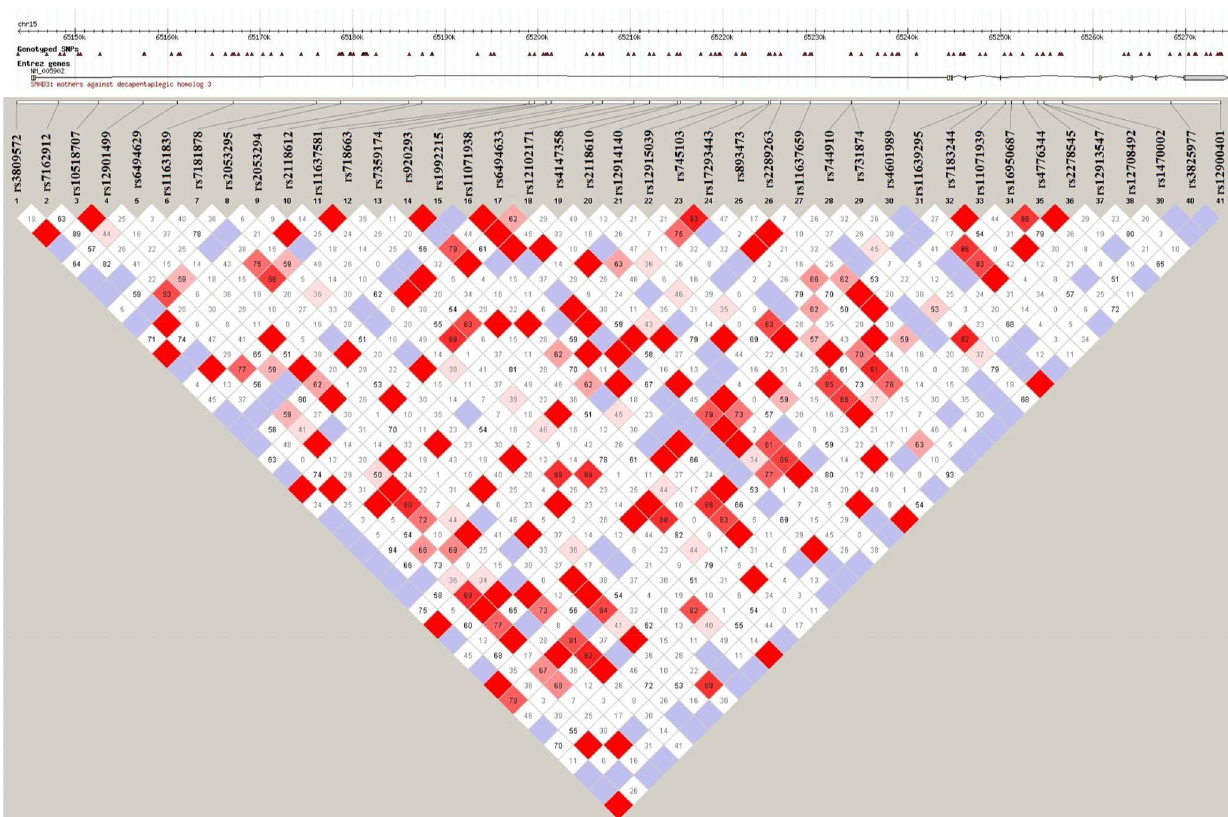
Figure 1. Distribution and LD pattern of 41 genotyped SNPs in SMAD3 gene.